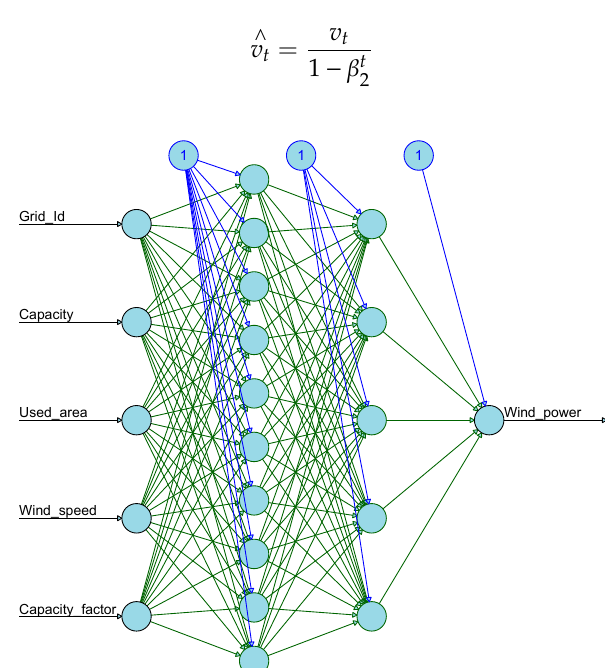
Figure 5. TensorFlow hidden layers with neurons with input and output using hourly wind turbine data.